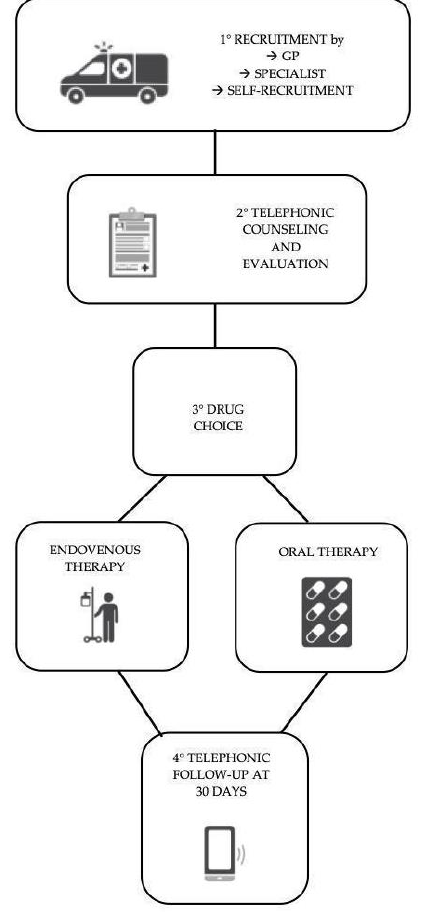
Figure 1. Patients’ recruitment algorithm.